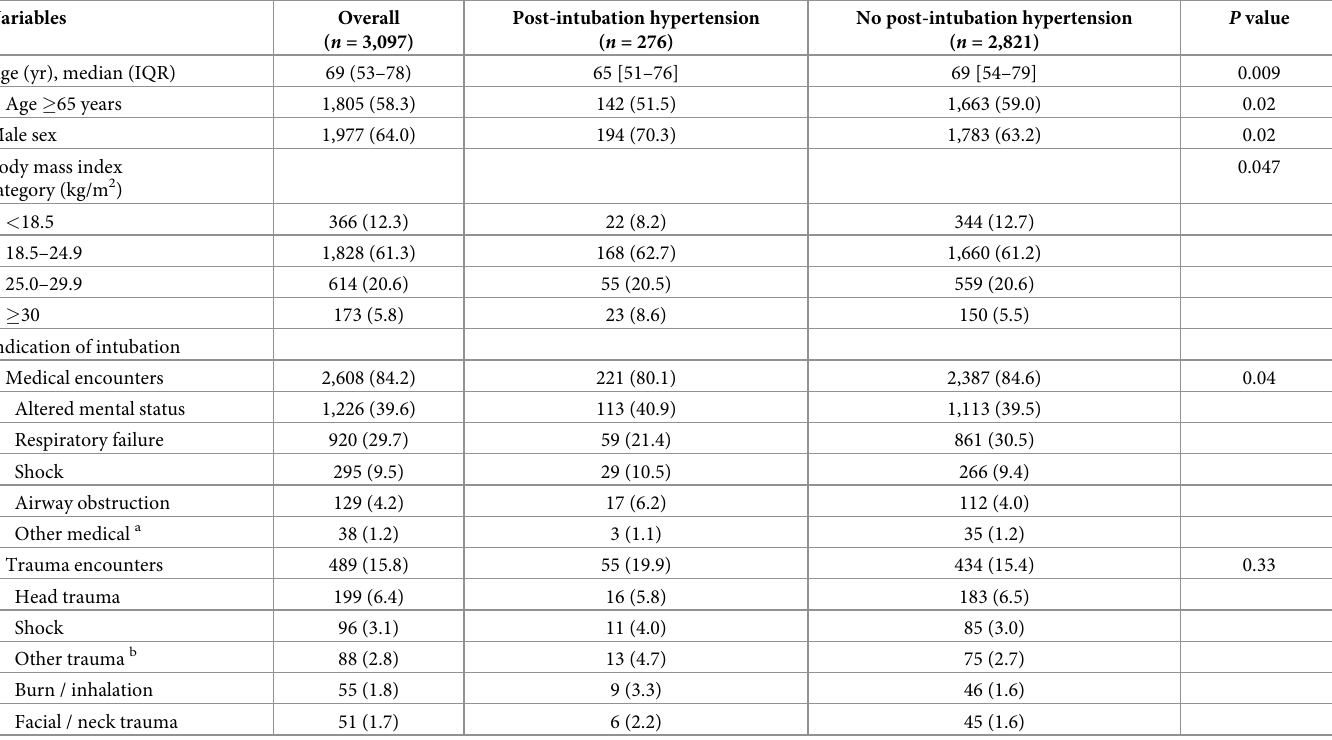
Table 1. Baseline characteristics of the study population, according to the